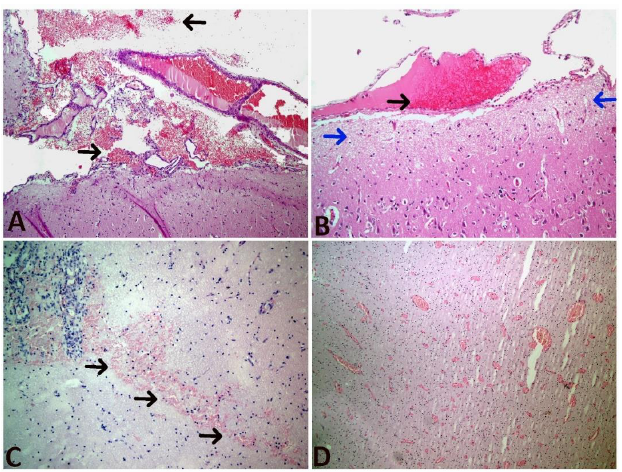
Figure 3. Microscopic photographs ( A ) Edema and hemorrhage in the meninges (arrows), HE, 10 × , ( B ) Hyperemia (black arrow) in the meningeal veins and edema in the submeningeal region (blue arrows), HE, 10 × , ( C ) Hemorrhage spreading to the neuropil tissue (arrows), HE, 20 × , ( D ) Severe hyperemia and vasodilation, HE, 10 ×